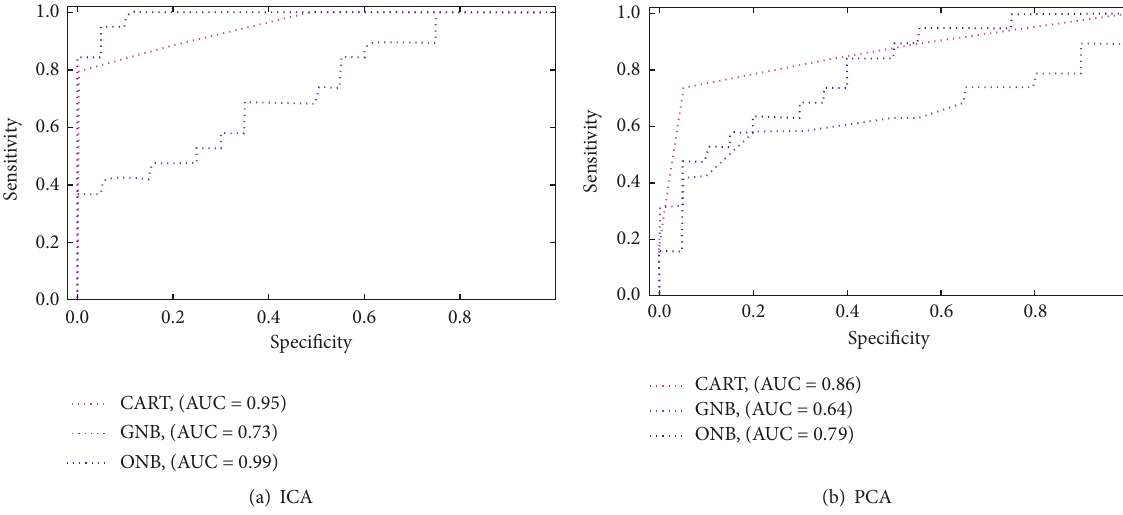
CART, (AUC = 0.95) GNB, (AUC = 0. 73 ) ONB, (AUC = 0.9 9 )